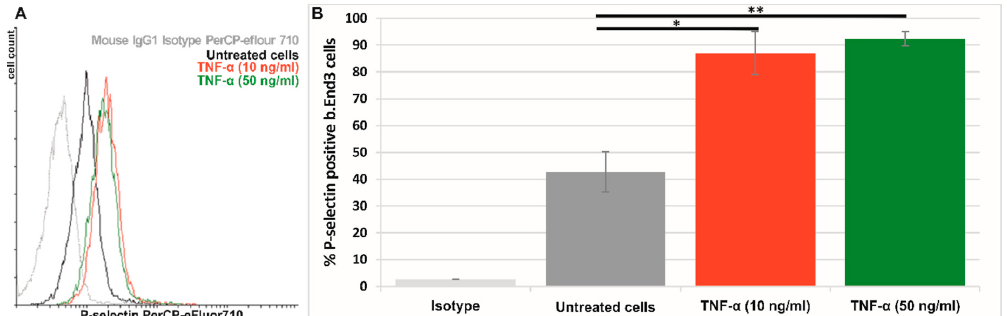
Figure 4. ( A ) Representative flow cytometry chart showing the expression of P-selectin on the surface of quiescent (untreated) (black line) and TNF- α activated bEnd.3 cells (red and green lines). ( B ) Percentages of P-selectin positive cells as determined by flow cytometry experiments and plotted from a single experiment using triplicate probes. Bar graph shows data as mean ± S.E.M (representative experiment made in triplicates). * p < 0.05, ** p < 0.01. 3.4.2. Psel-Lipo/siRNA Lipoplexes Are Specifically Internalized by TNF- α Activated Endothelial Cells